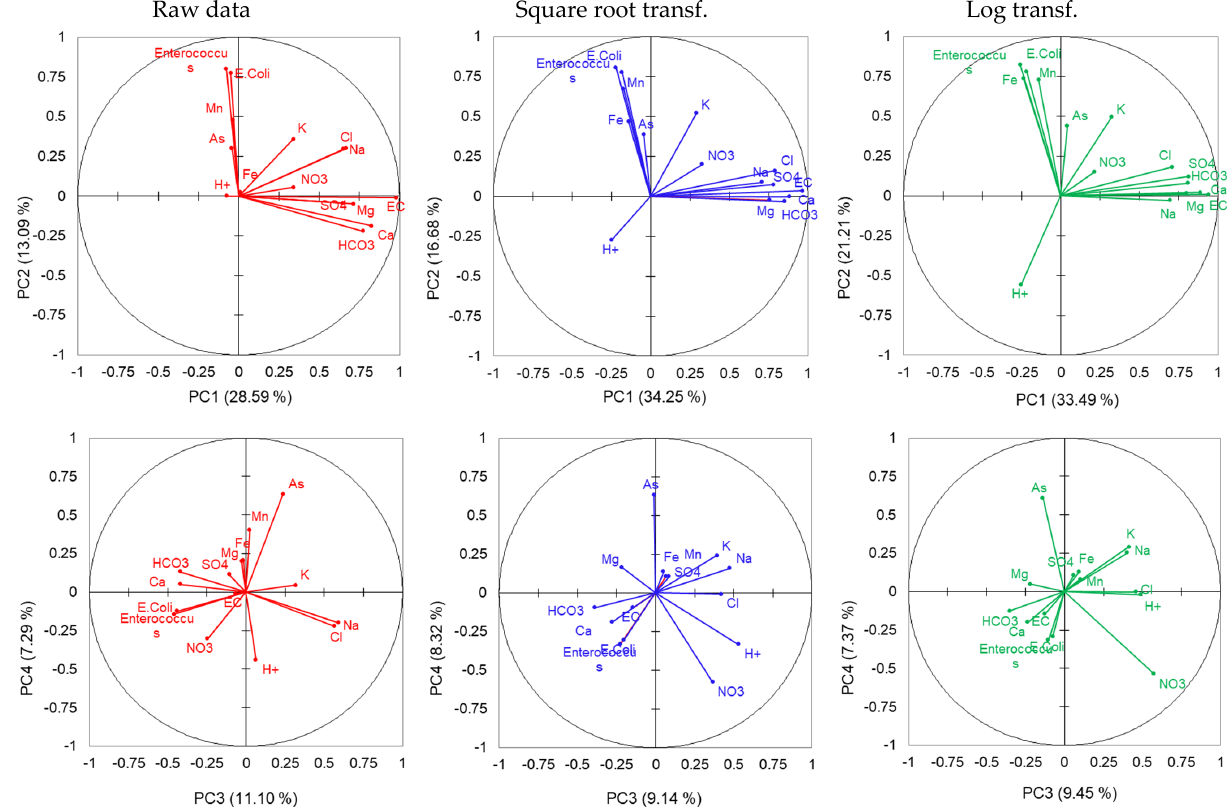
Figure 2. Distribution of the variables in the main factorial plans.